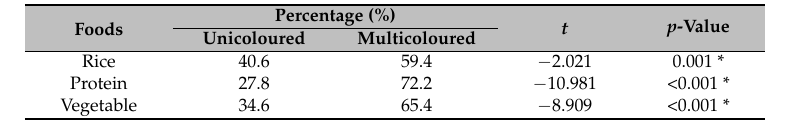
Table 10. Differences between foodscape (colour) preference based on food type ( n = 133).